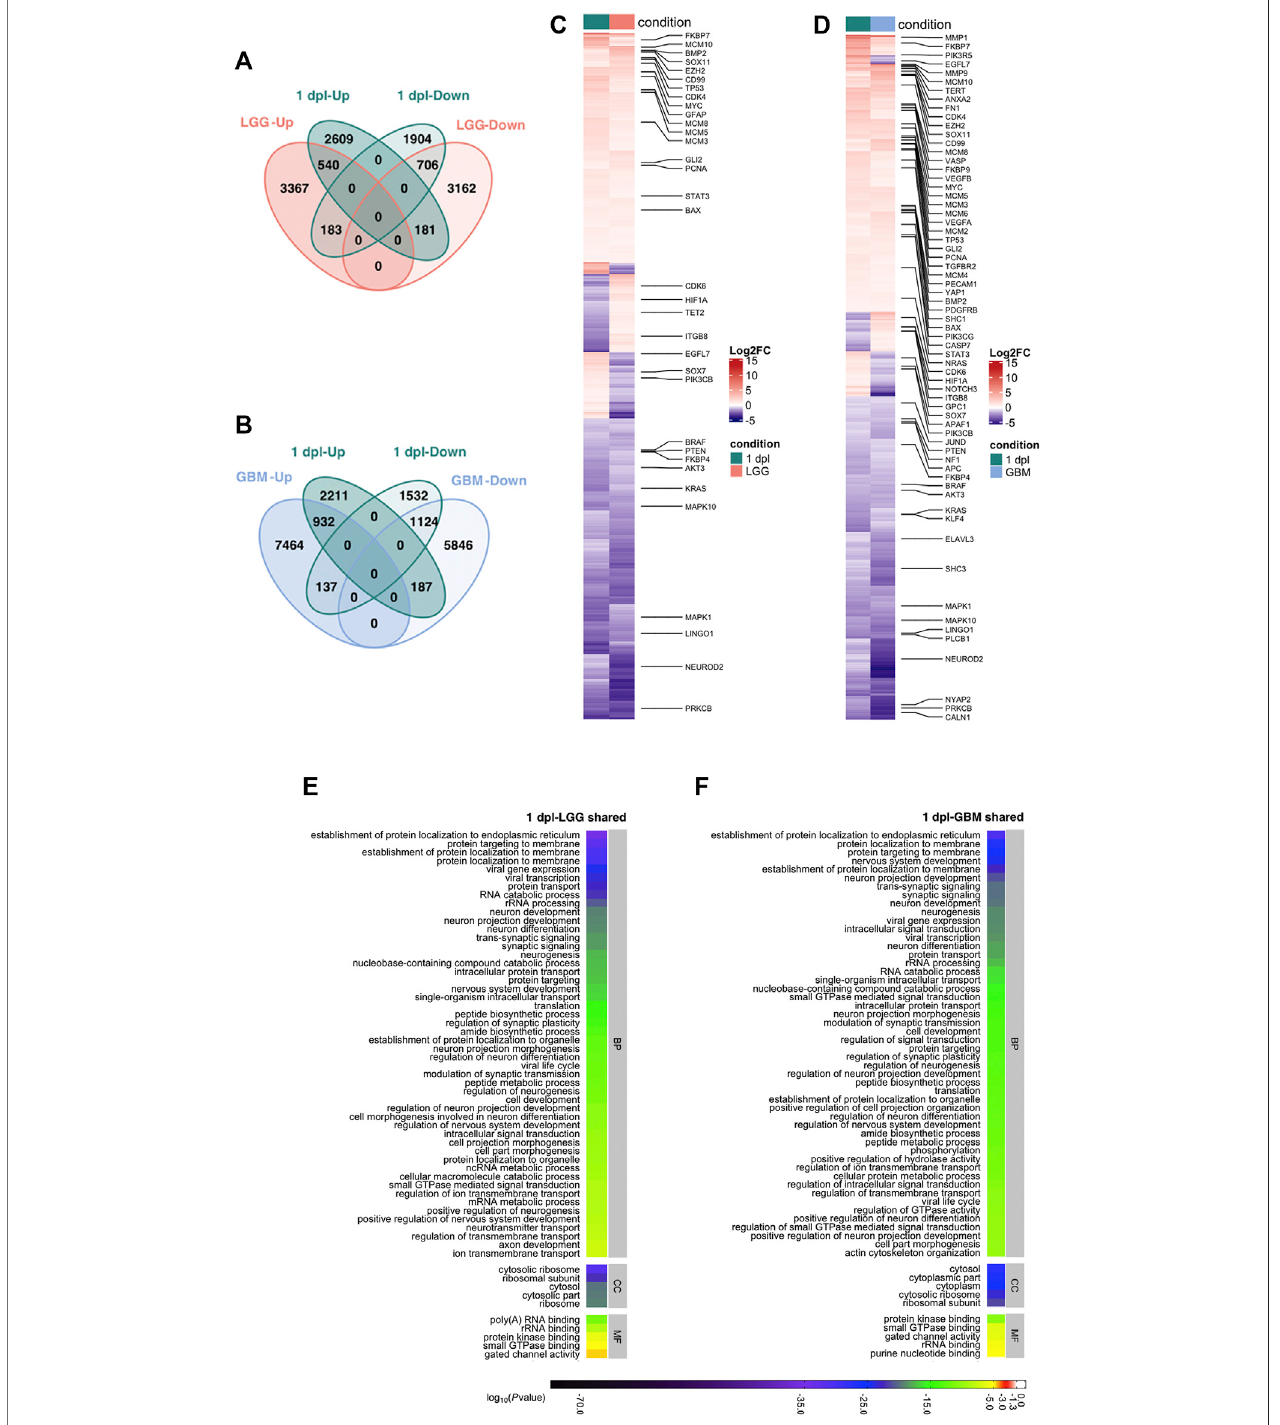
FIGURE 4 | Early wound healing stage (1 dpl) of brain regeneration is similar to brain cancer with respect to induction of metabolism- and neurogenesis-related signaling responses. (A, B) Venn diagrams showing the number of upregulated (Up) or downregulated (Down) DEGs and the overlap between 1 dpl (turquoise) and (A) LGG (pink) and (B) GBM (blue). (C, D) Heatmaps show the expression of genes shared between 1 dpl (turquoise) and (C) LGG (pink) and (D) GBM (blue). Each column representsacondition(1dpl,LGGorGBM)andeachrowshowsasinglegene.Thescalebarshowslog 2 foldchangesfromhightolowregulation,representedbya colorgradientfromredtopurple,respectively. (E,F) DAVIDwasusedtoshowthemostsigni fi cantlyenrichedGO-BP(top50),CC(top5),andMF(top5)termsbasedon transcriptional changes in comparison of 1 dpl with (E) LGG and (F) GBM by using human identi fi ers of shared DEGs. The heatmap scale shows log 10 of the ease p -values for the most signi fi cantly enriched GO terms. dpl: days post-lesion, DAVID: database for Annotation, Visualization and Integrated Discovery, GO: Gene Ontology, BP: Biological Process, MF: Molecular Function, CC: Cellular Component, dpl: days post lesion, LGG: low-grade glioma, GBM: glioblastoma.